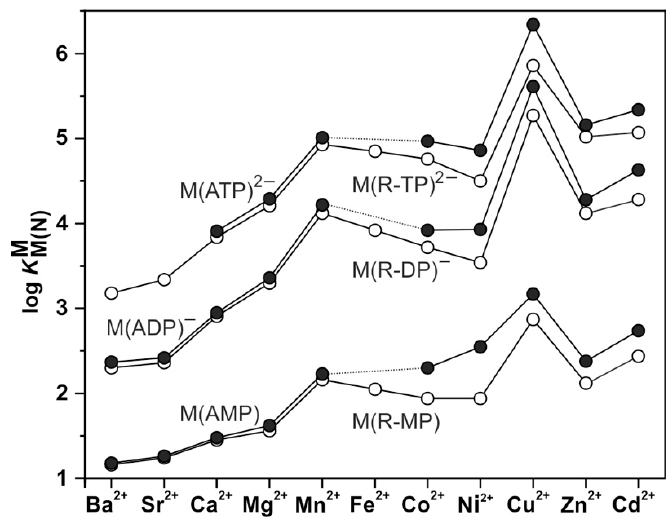
Figure 21. Irving–Williams sequence-type plots [158] for the stability constants log K M(N)M (N = nu- cleotide) of the 1:1 complexes of Ba 2+ through Cd 2+ formed with mono- (R-MP 2 − ), di- (R-DP 3 − ), and triphosphate monoesters (R-TP 4 − ) ( ◯ ), as well as of those for AMP 2 − , ADP 3 − , and ATP 4 − (  ). The plotted data of the phosphate ligands are from Table 13 of [23]; they also represent the stability constants for the M 2+ complexes of the pyrimidine-nucleoside 5 ′ -mono-, di- or triphosphates (except for Cu(CTP) 2 − [74]). The log stability constants for the M 2+ complexes of AMP 2 − and ADP 3 − are from Table 4 of [153]; those for ATP 4 − are from Table II of [74] (25 °C; I = 0.1 M, NaNO 3 ) ([23,74,163,164] as well as pp. 364–365 in